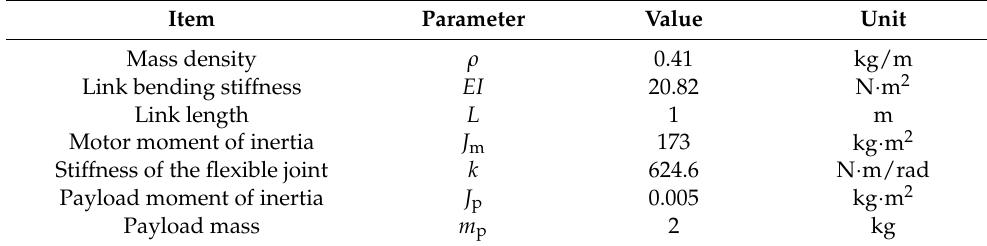
Table 1. Geometrical and Material Parameters of an SFF manipulator.